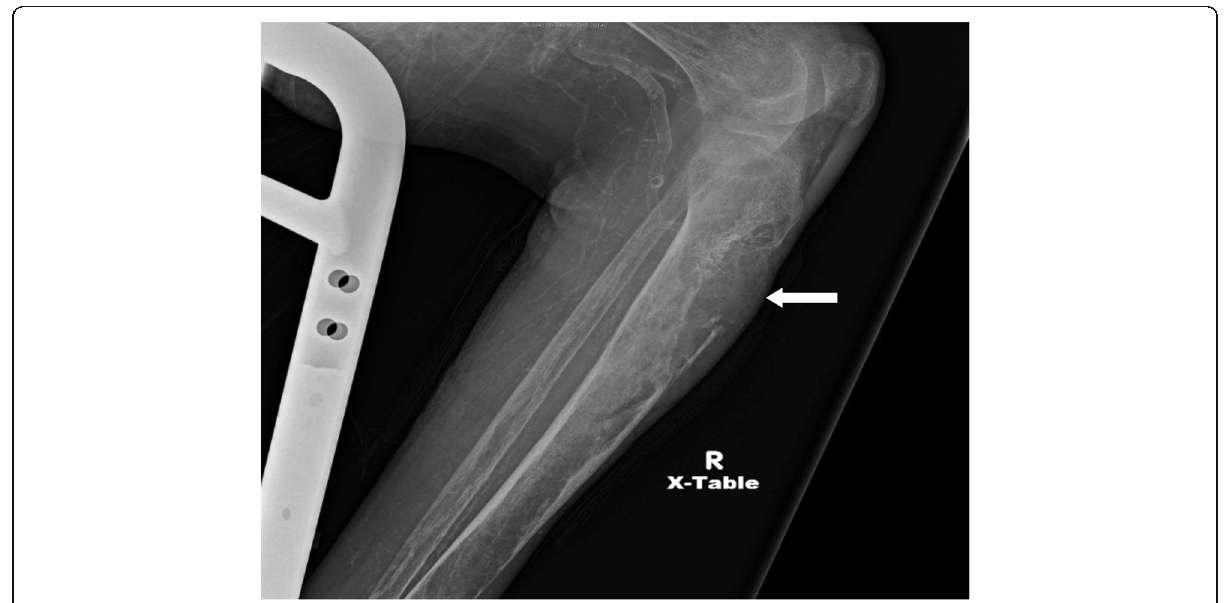
Fig. 1 Radiologic examination showed a large osteolytic lesion with pathologic fracture affecting the medial aspect of the proximal tibia with extensive soft tissue